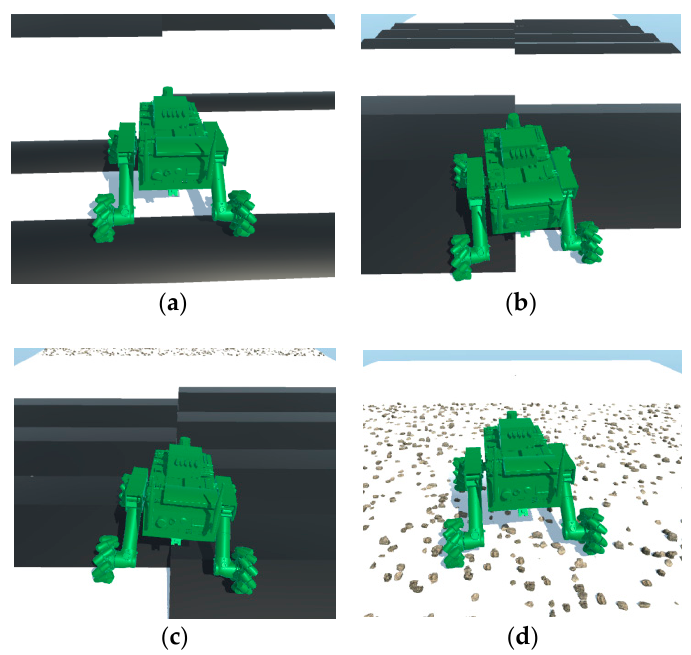
during its movement. The curve in Figure 31 reflects the effect of the obstacle on the center height of